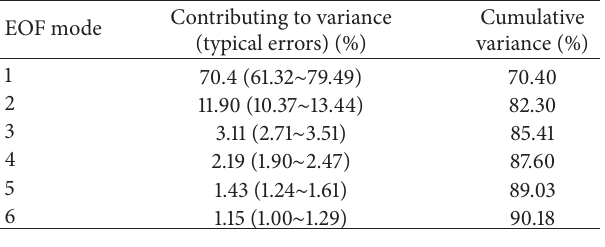
Table 3: The contribution of eigenvalue at each EOF mode of AOT F. Contributing to variance EOF mode